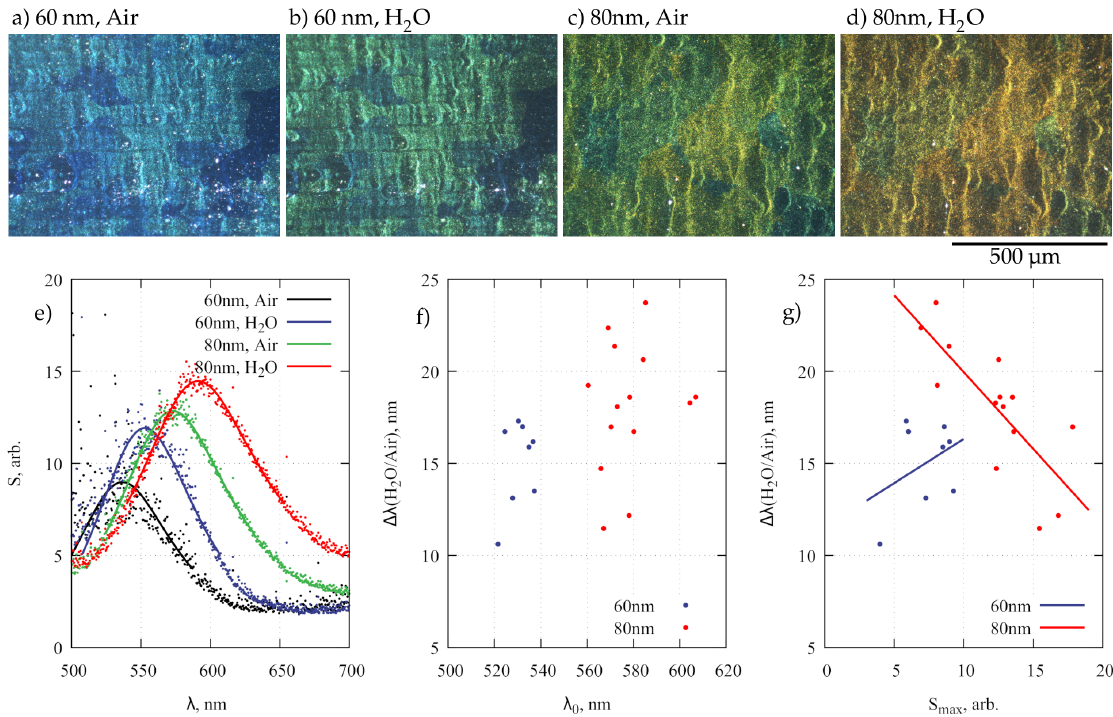
Figure 3. ( a – d ) Dark-field photographs of 60 and 80 nm NPAs on Al-NAA substrate in air and water illuminated by s-polarized white light. ( e ) Typical scattering spectra from samples ( a – d ), where the same spot was examined in air and water. ( f ) medium dependent (air/water) spectral shift of peak wavelength ∆ λ as a function of peak wavelength in air, and ( g ) spectral shift dependence on scattering maximum amplitude S max